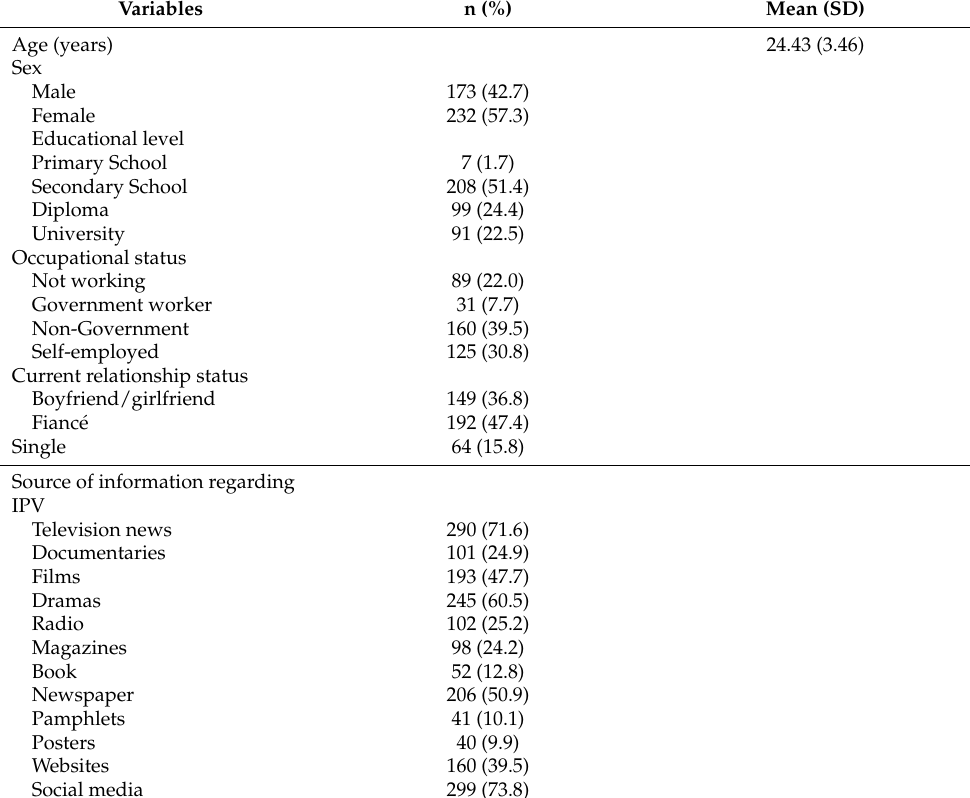
Table 1. Characteristics of the respondents (n =